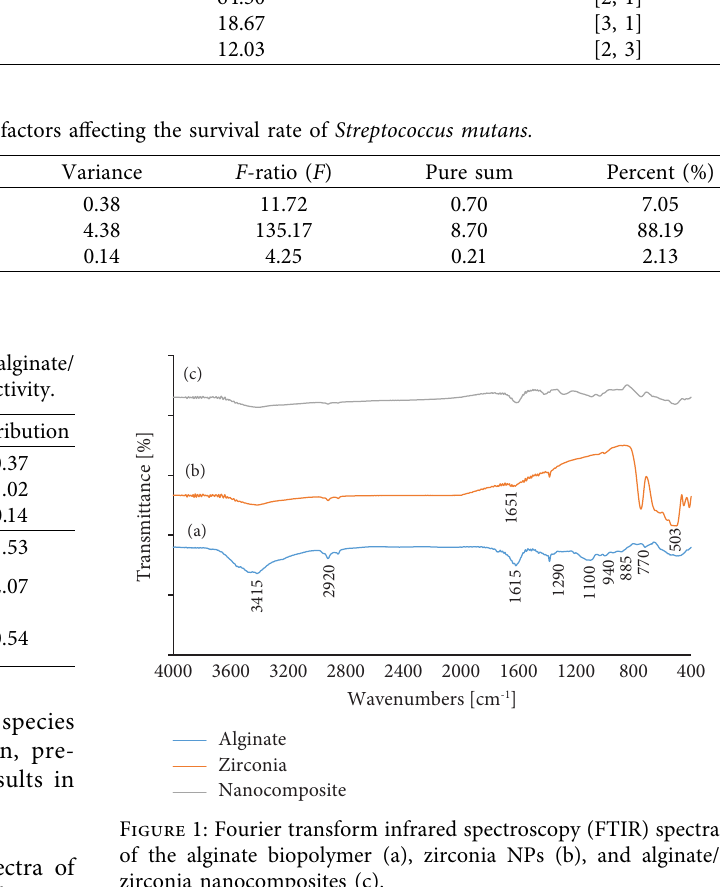
Table 3: Te interaction efects of studied factors on the survival rate of Streptococcus mutans. Interacting factor pairs